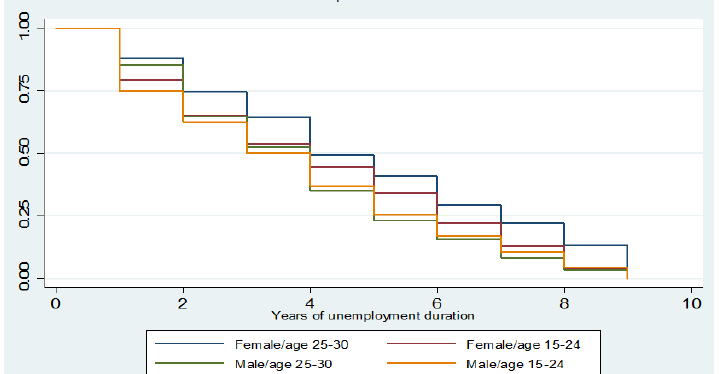
Figure 6: Survival function estimates by gender and for the age groups